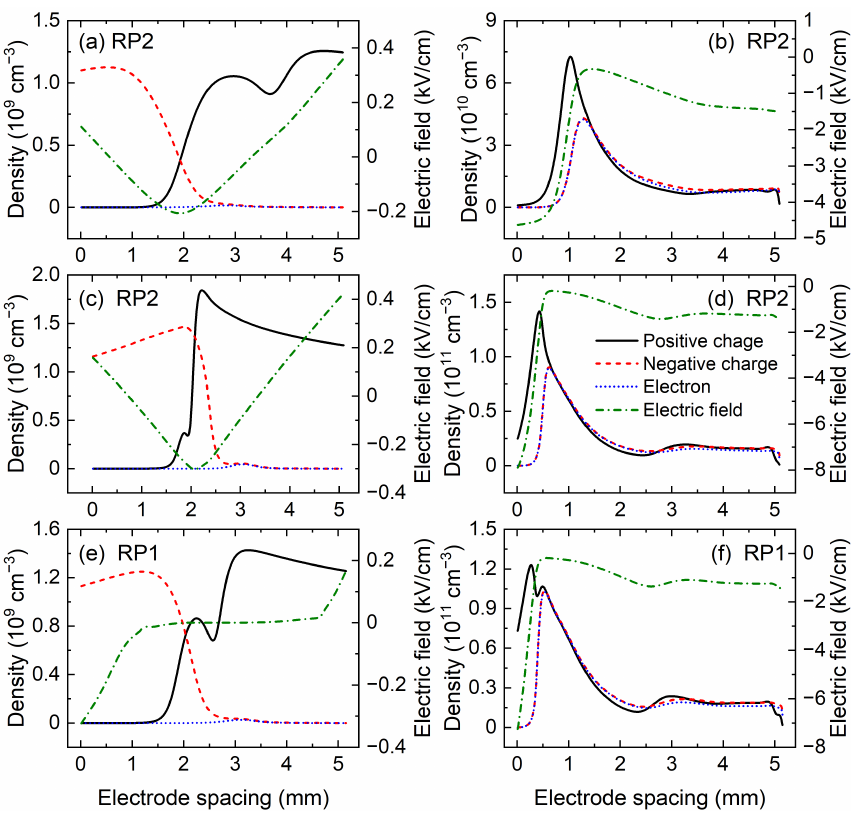
Figure 10. Spatial distributions of positive charge density, negative charge density, electron density, and electric field at several key moments in RP2 discharge and RP1 discharge.